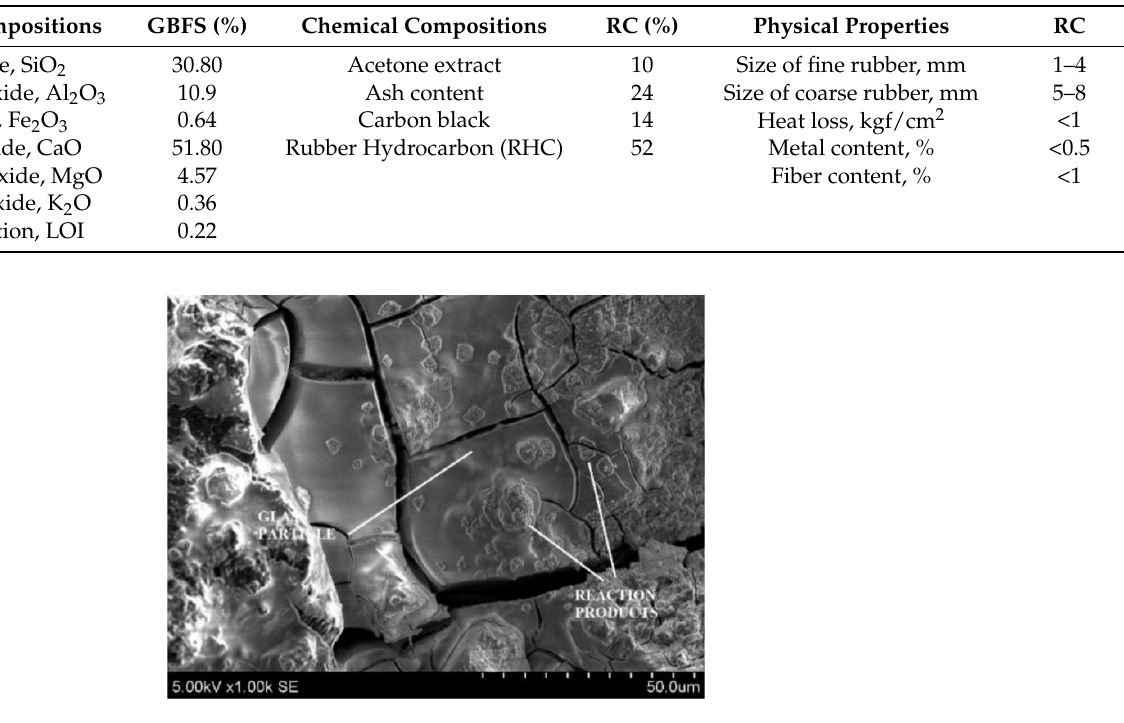
Figure 18. SEM images of glass waste particles [60].